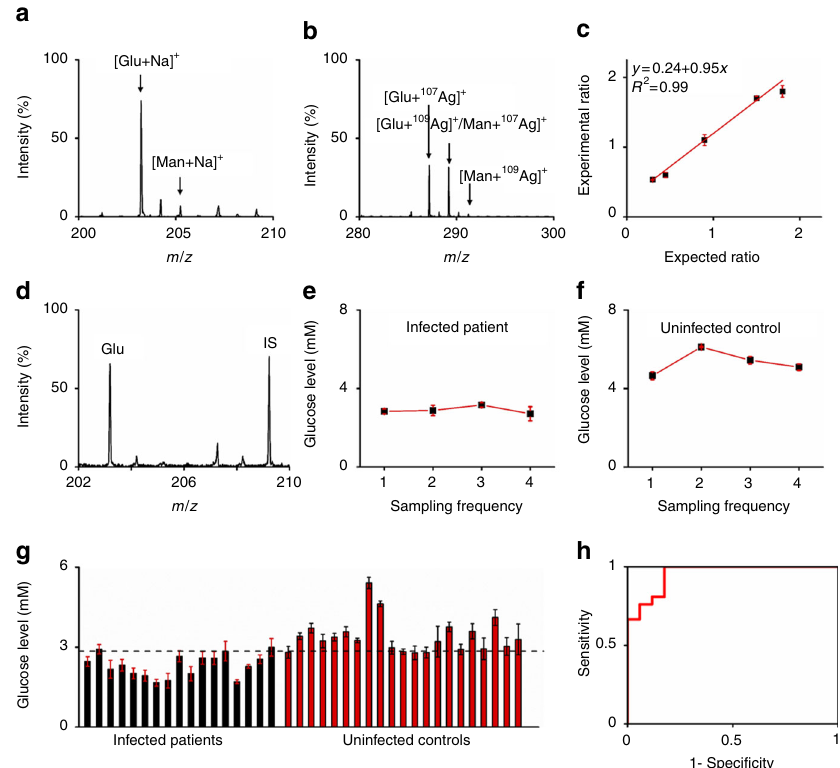
Fig. 3 Postoperative brain infection diagnosis based on glucose quantitation. Mass spectra of 0.5 μ L of native CSF showing a sodium-adducted and b silver- adducted characteristic molecular peaks of glucose and mannitol; c the calibration curve obtained by plotting experimental ratio of analyte/isotope (A/I) as a function of expected ratio of A/I for glucose; d typical mass spectrum of glucose and its isotope as internal standards (A/I, 1/1). The isotope (IS) contained six 13 C. Glucose levels as measured in CSF from the e infected patient and f uninfected control in consecutive 4 days. g Glucose levels in CSF samples using the particle-assisted LDI MS and h the corresponding ROC curve showing the diagnostic sensitivity and speci fi city. The optimized threshold (2.85 mM) according to the ROC curve was denoted by the dotted line . Five independent experiments were performed for each sample to calculate the standard deviation (s.d.) as error bars . Data were shown as the mean ± s.d. ( n =